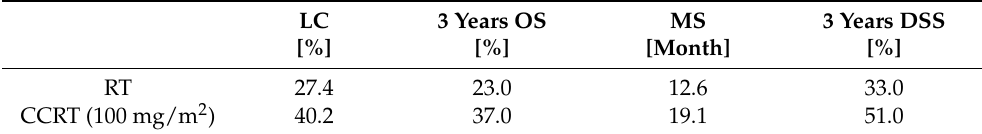
Table 2. Clinical trial 1 RT vs. CCRT.